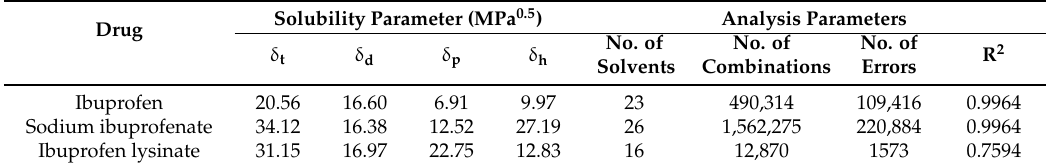
Table 4. The values of solubility parameters for ibuprofen, sodium ibuprofen and ibuprofen lysinat obtained by using EHA.